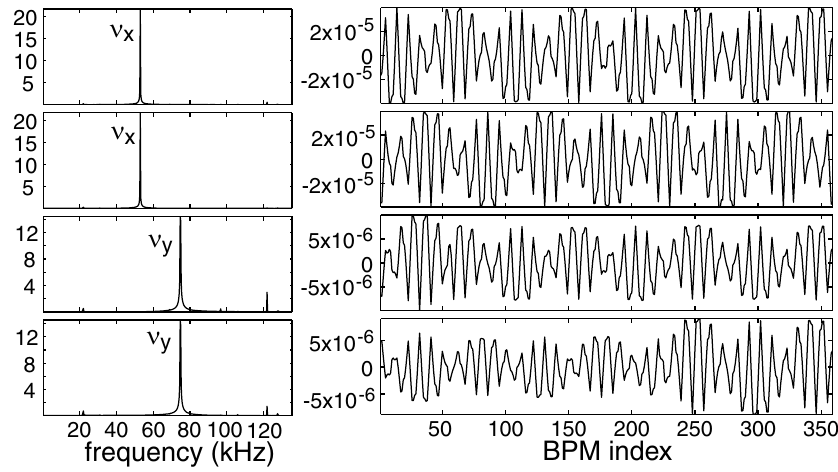
FIG. 2. Modes of Fig. 1 after a rotation to untangle mixing.